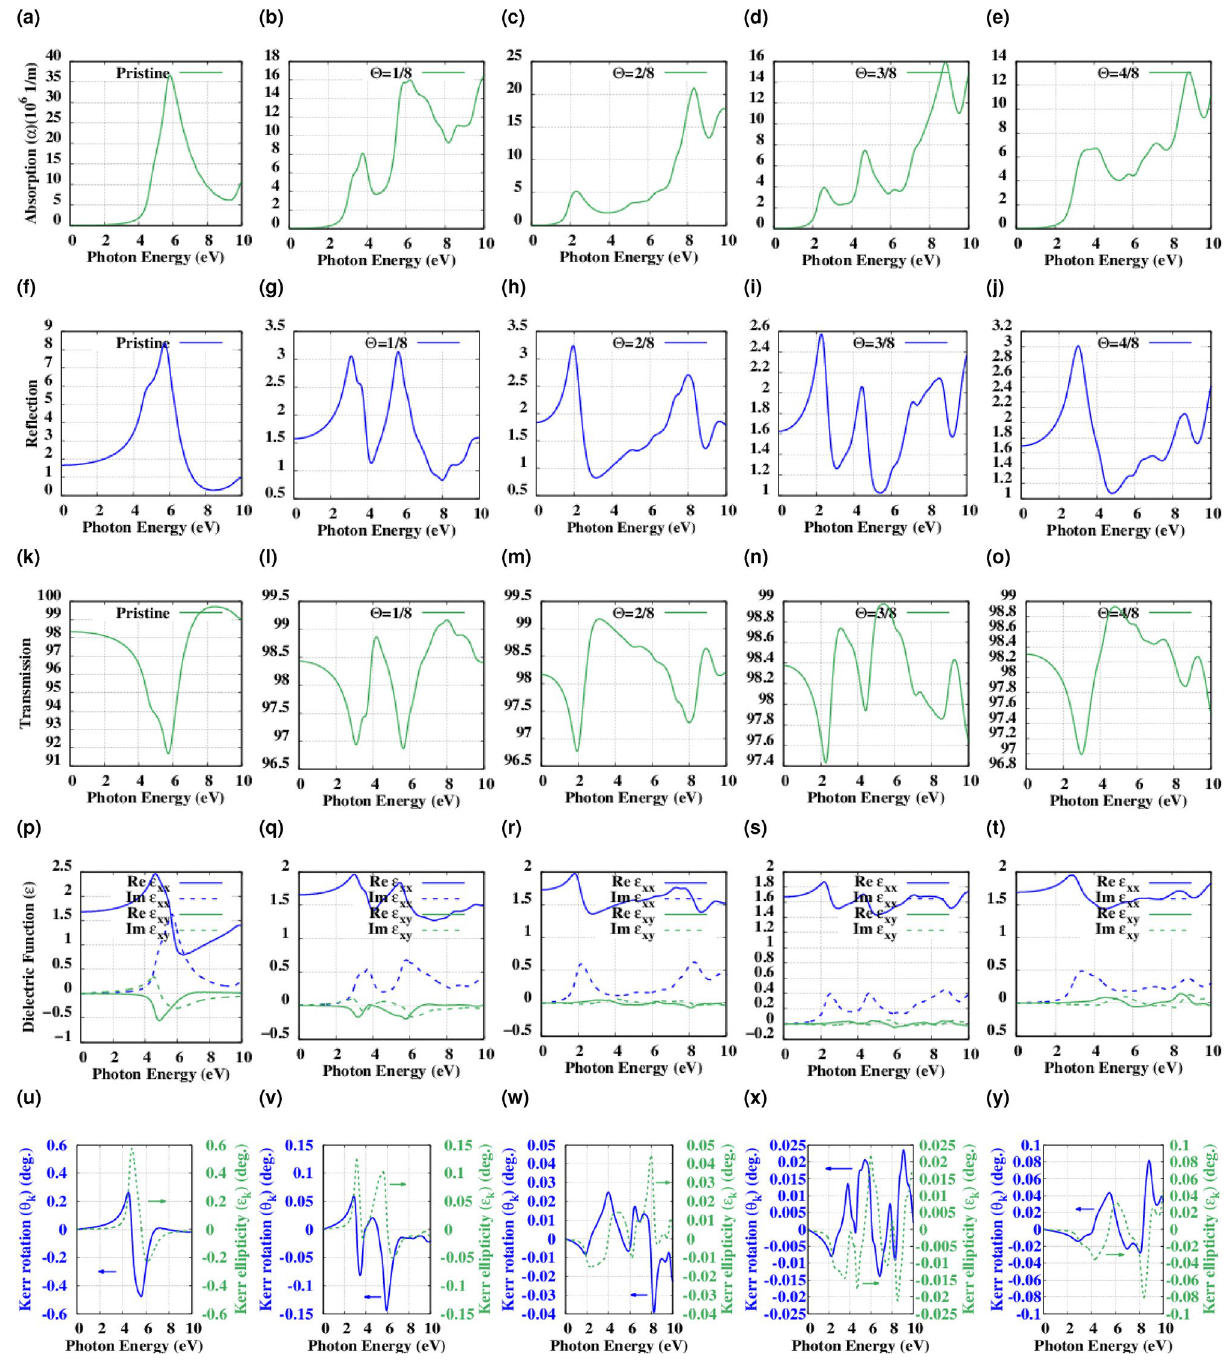
Figure 8. ( a ) The optical absorption spectrum for the pristine hBN. ( b – e ) The optical absorption spectrum for the (cid:31) = 1/8, 2/8, 3/8, and 4/8 functionalized hBN. ( f ) Calculated spectra of reflection for Pristine hBN. ( g – j ) Calculated spectra of reflection for the (cid:31) = 1/8, 2/8, 3/8, and 4/8 functionalized hBN. ( k ) Calculated spectra of Transmission for Pristine hBN. ( l – o ) Calculated spectra of transmission for the (cid:31) = 1/8, 2/8, 3/8 and 4/8 functionalized hBN. ( p ) Calculated real part (solid lines) and imaginary part (dashed lines) of both diagonal ε xx (blue) and off-diagonal ε xy (green) dielectric functions of the pristine hBN. ( q – t ) to calculated real part (solid lines) and imaginary part (dashed lines) of both diagonal ε xx (blue) and off-diagonal ε xy (green) dielectric functions of the (cid:31) = 1/8, 2/8, 3/8, and 4/8 functionalized hBN. ( u ) Kerr angle θ K (left, blue solid) and Kerr ellipticity χ K (right, green dashed) of the pristine hBN. ( v – y ) Kerr angle θ K (left, blue solid) and Kerr ellipticity χ K (right, green dashed) of the (cid:31) = 1/8, 2/8, 3/8, and 4/8 functionalized hBN in the P-MOKE